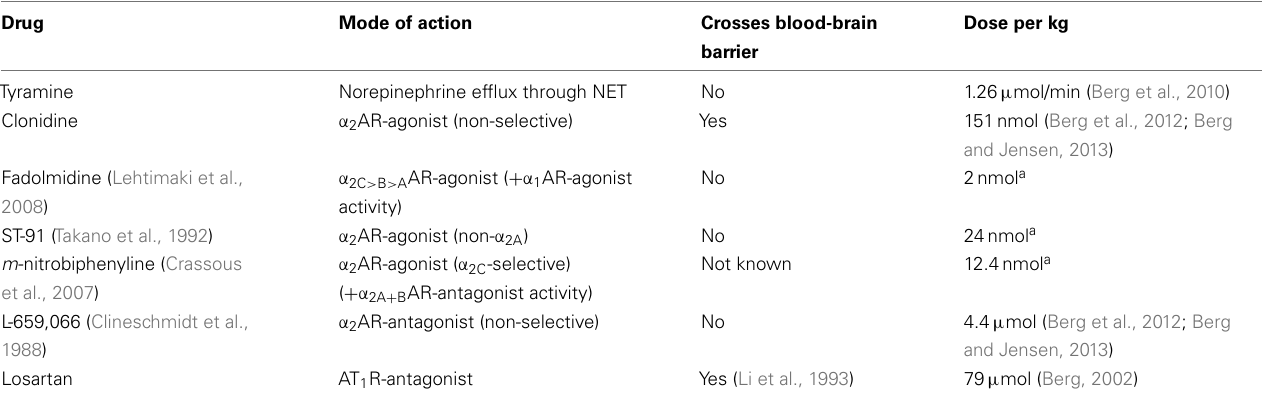
Table 1 | Mode of action and dose of the pharmacological agents